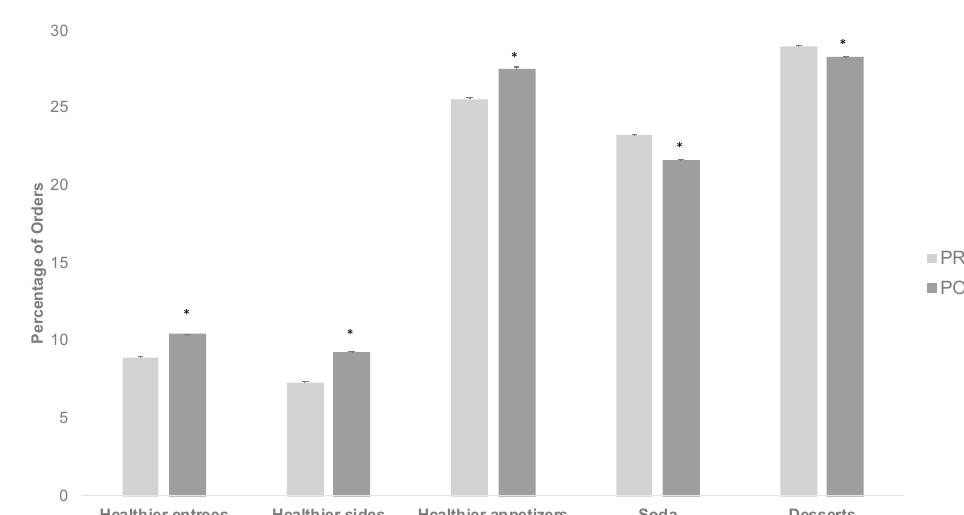
Figure 1. Healthier adult menu orders from before (PRE) to after (POST) the new healthier children’s menu. The healthier children’s menu was implemented in April 2012 at standard locations of a regional restaurant chains. The PRE period (before the healthier children’s menu was implemented) was September 2011 to March 2012. The POST period (after the healthier children’s menu was implemented) was September 2012 to March 2013. Items classified as healthier were designated as healthier options on the adult menu. Orders of soda and entrées that included desserts were also evaluated. * denotes that PRE to POST differences in the percentage of orders that included healthier items, soda, or dessert were statistically significant based on McNemar tests of paired proportions; asymptomatic p- values for all tests <0.0001. Standard errors are also shown.